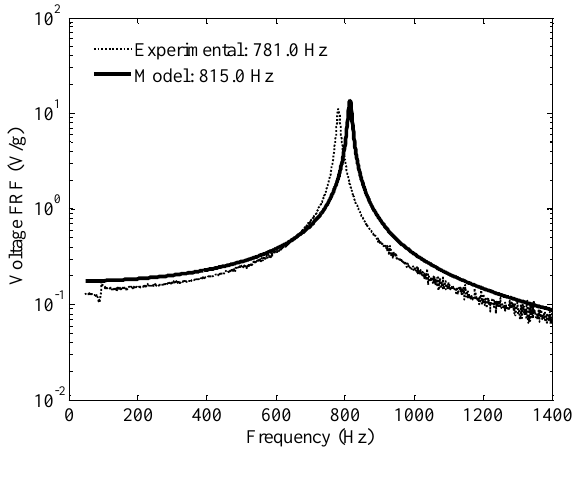
Figure 17. Theoretical and experimental FRF (open circuit condition).